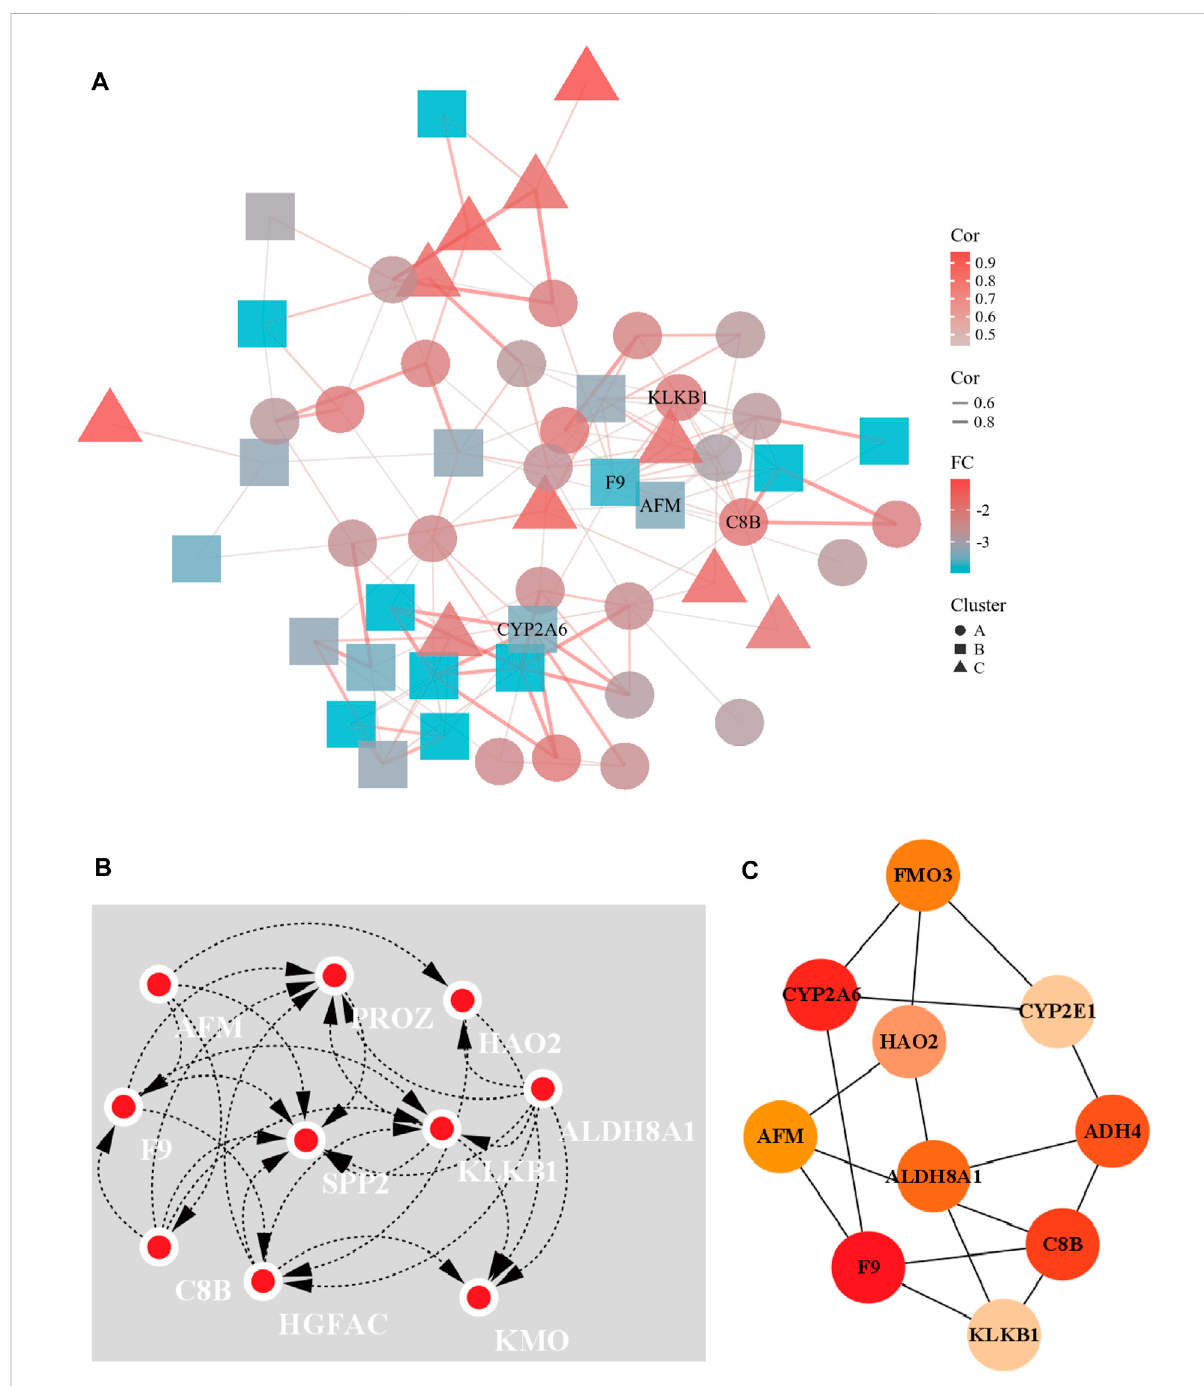
FIGURE 4 The PPI network of down-regulated DEGs and the interaction network of hub genes. (A) The PPI network of the 81 down-regulated DEGs. (B) Eccentricitytopologicalmethodwasusedtoidentifydown-regulatedhubgenes. (C) Top10hubgenenetworkconstructedbyclosenesstopological